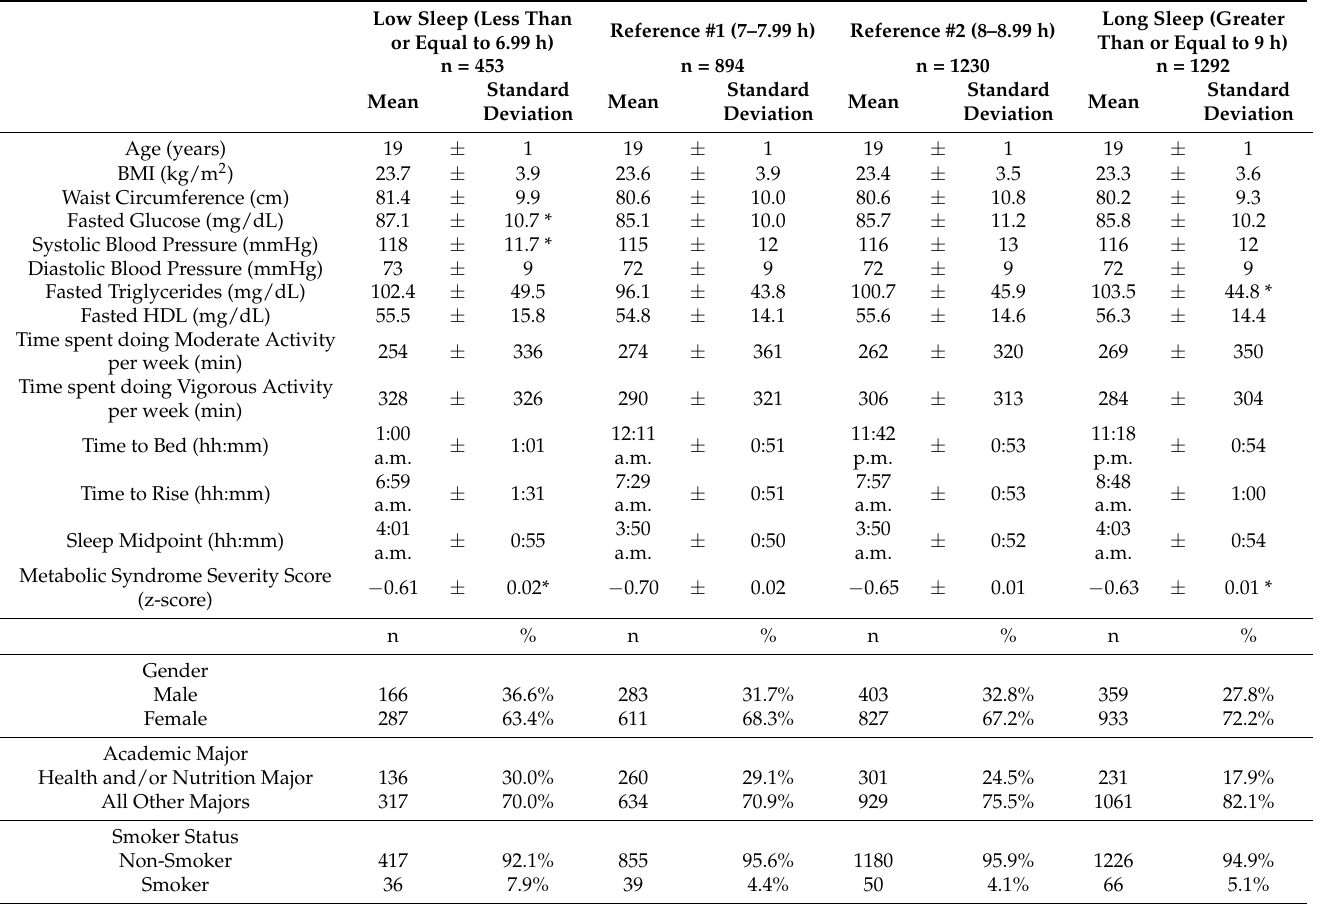
Table 2. Participant